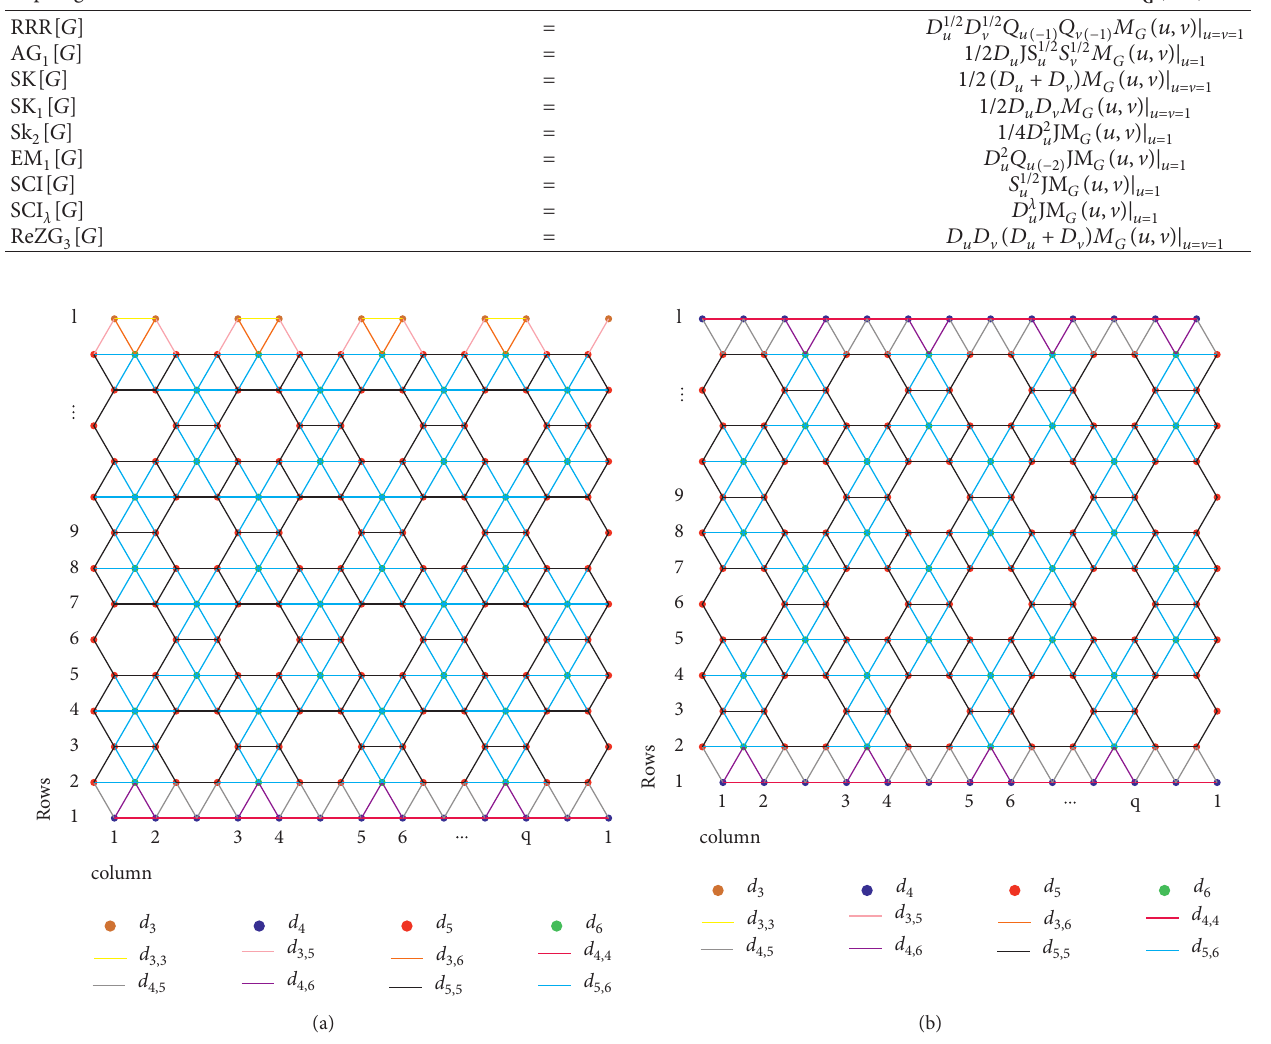
Figure 1: Boron α -nanosheet B